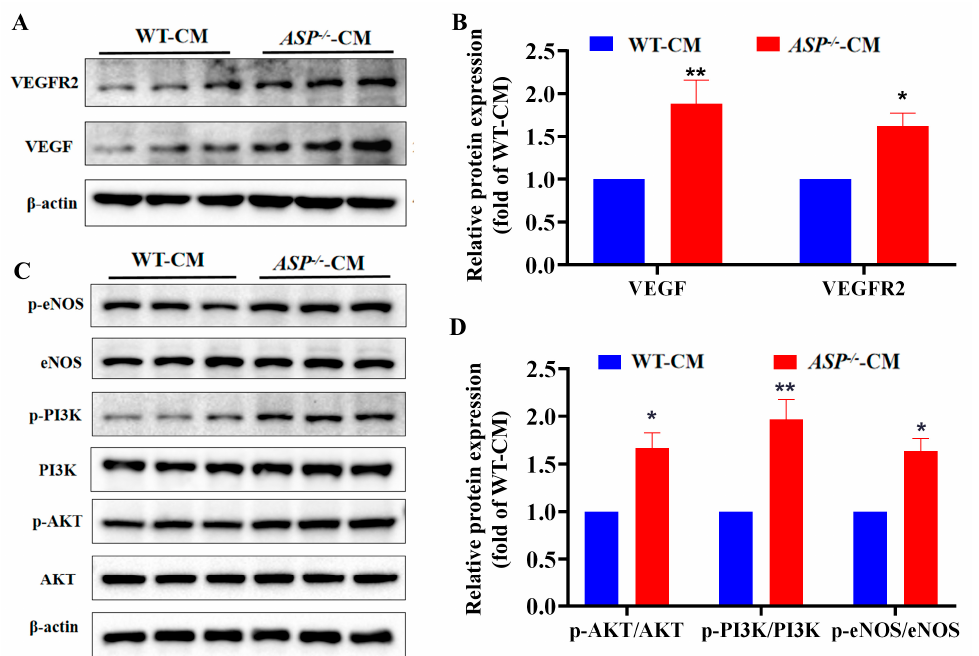
Figure 4. ASP -knockout enhances VEGF/VEGFR2 and PI3K/AKT/eNOS signaling in vitro . HUVECs were treated with ASP -/- -CM or WT-CM for 48 h and total proteins were extracted and quantified. Expression levels of VEGF/VEGFR2 pathway proteins ( A , B ) and PI3K/AKT/eNOS pathway proteins were analyzed by Western blots ( C , D ). Data are presented as mean ± SEM from three independent experiments ( n = 3). An unpaired two-tailed Student’s t -test was used for the comparison between two groups. * p < 0.05, ** p < 0.01, vs. the WT-CM group. WT-CM: conditional medium from WT-3T3-L1 adipocytes; ASP -/- -CM: conditional medium from ASP -/- -3T3-L1 adipocytes. ASP : asprosin, VEGF: vascular endothelial growth factor, VEGFR2: vascular endothelial growth factor receptor 2; PI3K: Phosphatidylinositol 3-kinase, AKT: protein kinase B, eNOS: endothelial nitric oxide synthase.